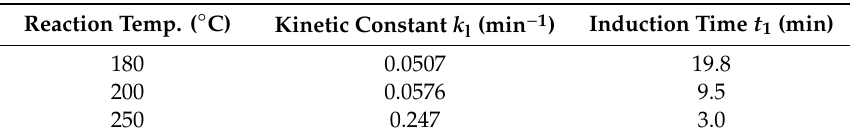
Table 4. Kinetic constant and induction time of the water-soluble content (WSC) ratio of polylactic acid